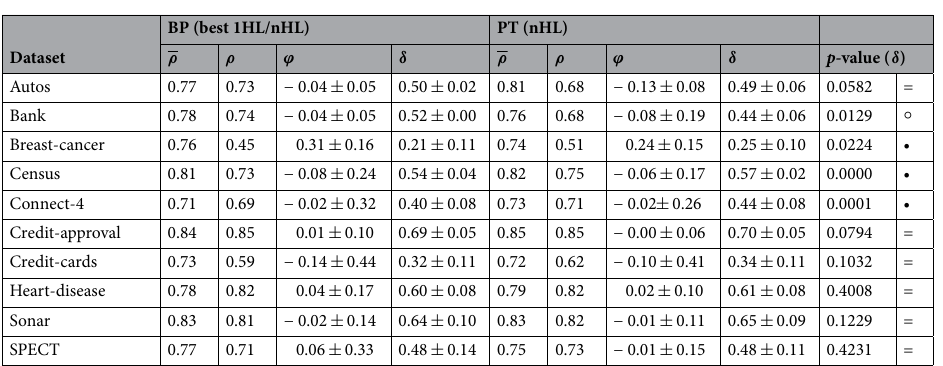
Table 2. Comparison, with focus on δ (and on ϕ ), between BP and PT applied to non trivial datasets (all from UCI). The comparison is in fact focused on unbiased accuracy—i.e., on the accuracy measured as datasets were in fact balanced. Results in favour of/against PT are highlighted with black/white circles, whereas results with no significant difference are highlighted with an equal sign. Standard deviation is reported for both ϕ and δ